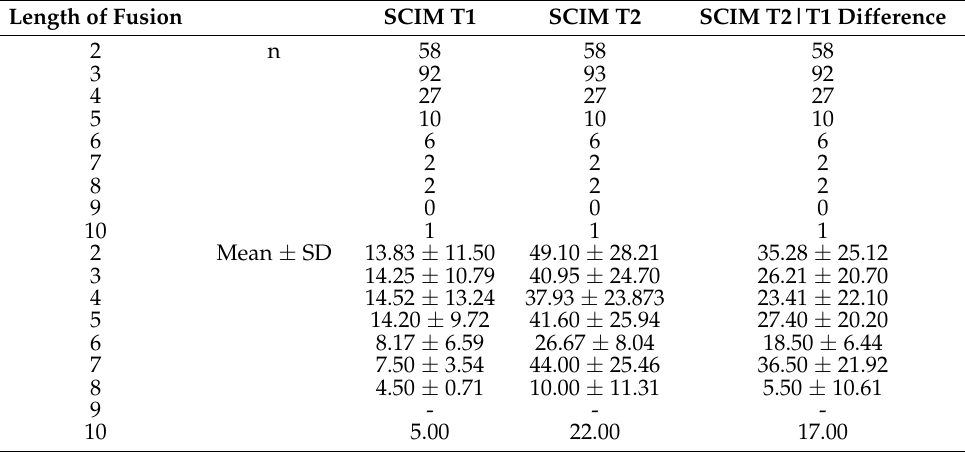
Table 5. SCIM values at admission and discharge divided by fusion length. Length of Fusion